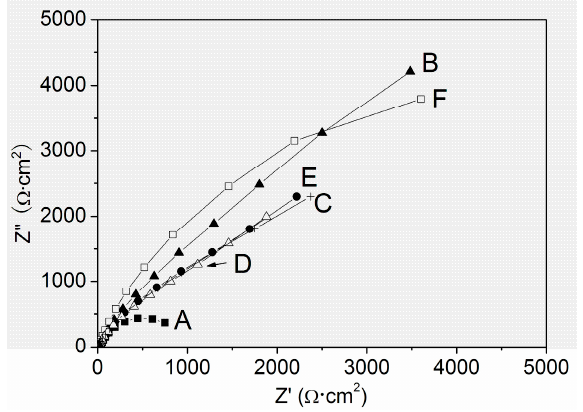
Figure 10. The Nyquist plots at the E OCP for X70 carbon steel electrodes in 0.10 mol/L NaCl + c a mol/L Na 3 PO 4 + c b mol/L NaNO 2 solutions (A) c a = 0, c b =0; (B) c a = 0.040, c b =0; (C) c a = 0.030, c b = 0.010; (D) c a = 0.020, c b = 0.020; (E) c a = 0.010, c b = 0.030; (F) c a = 0, c b = 0.040.